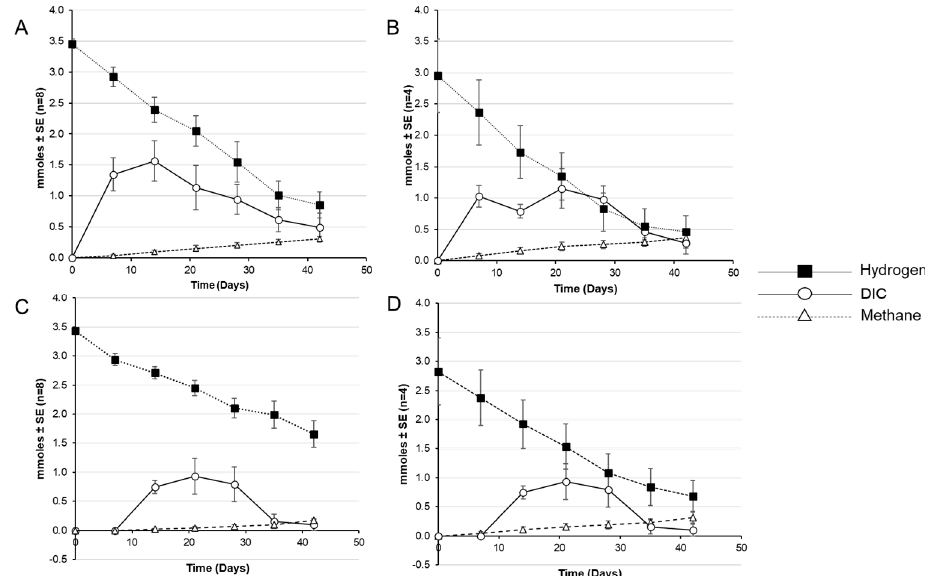
Figure 2. Consumption of hydrogen and generation of dissolved inorganic carbon/methane from calcium carbonate incubated with hydrogenotrophic enrichments from lime ( A ) and steel ( B ) sedi- ments, or marble chips incubated with hydrogenotrophic enrichments from lime ( C ) and steel ( D )